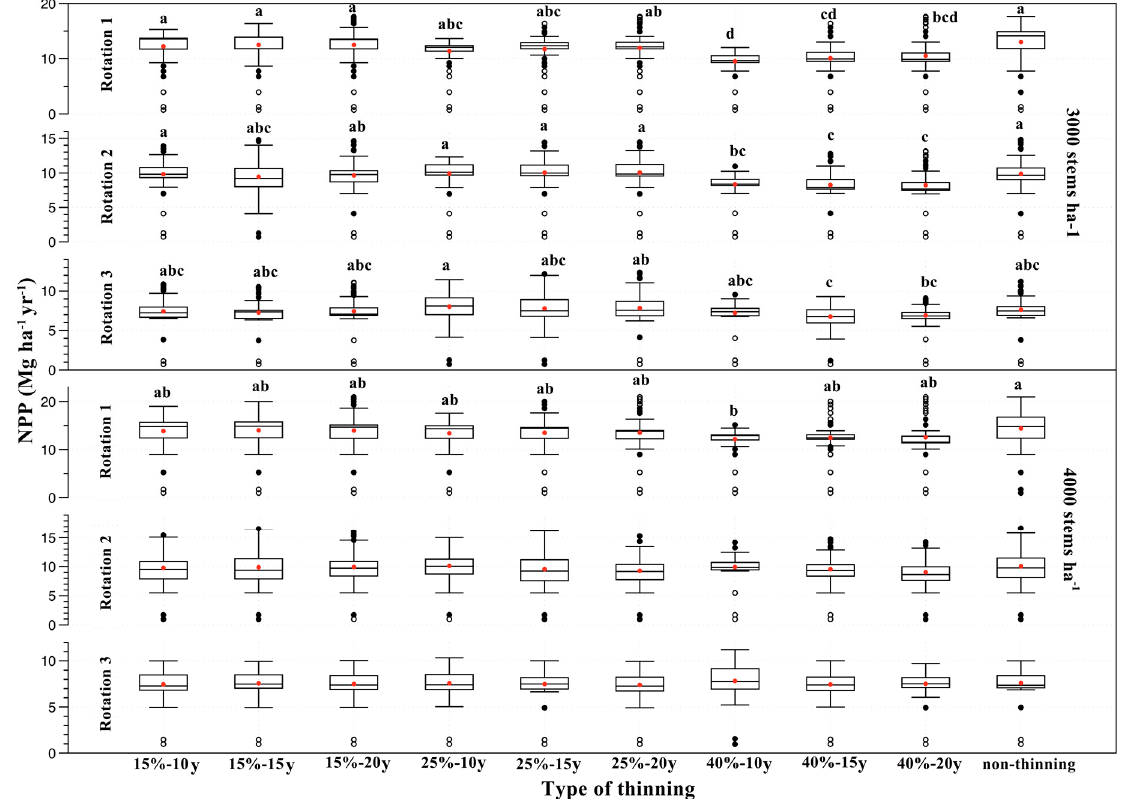
Figure 3. Distribution of simulated NPP in different rotations and stand densities for different thinning types. The red dot indicates the average NPP. Different letters indicate significant differences between thinning types with Tukey HSD (honest significant difference) test at p < 0.05. Table 2. Difference in accumulated NPP per rotation between thinning and non-thinning treatments. Positive values mean that the accumulated NPP in a rotation increased due to management compared with the non-thinning treatment. Maximum values in bold.